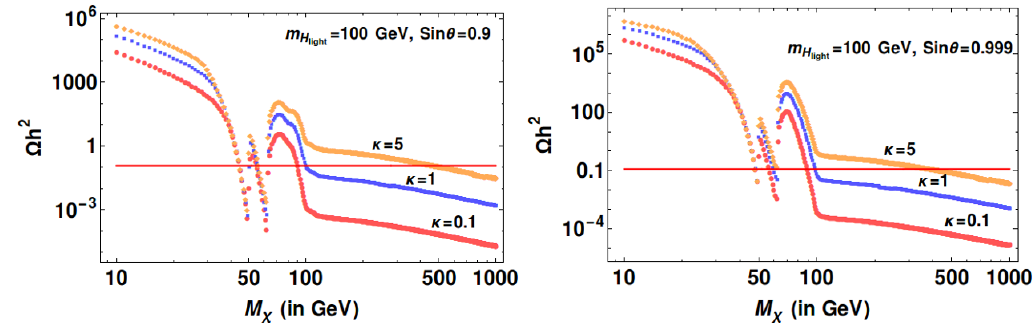
Figure 16 . Relic density vs DM mass for various (cid:20) (= (cid:21) 1 =(cid:21) 2 ) values in the low mass region. Here, orange, blue and red dotted lines stands for (cid:20) = 5, (cid:20) = 1 and (cid:20) = 0 : 1 respectively.